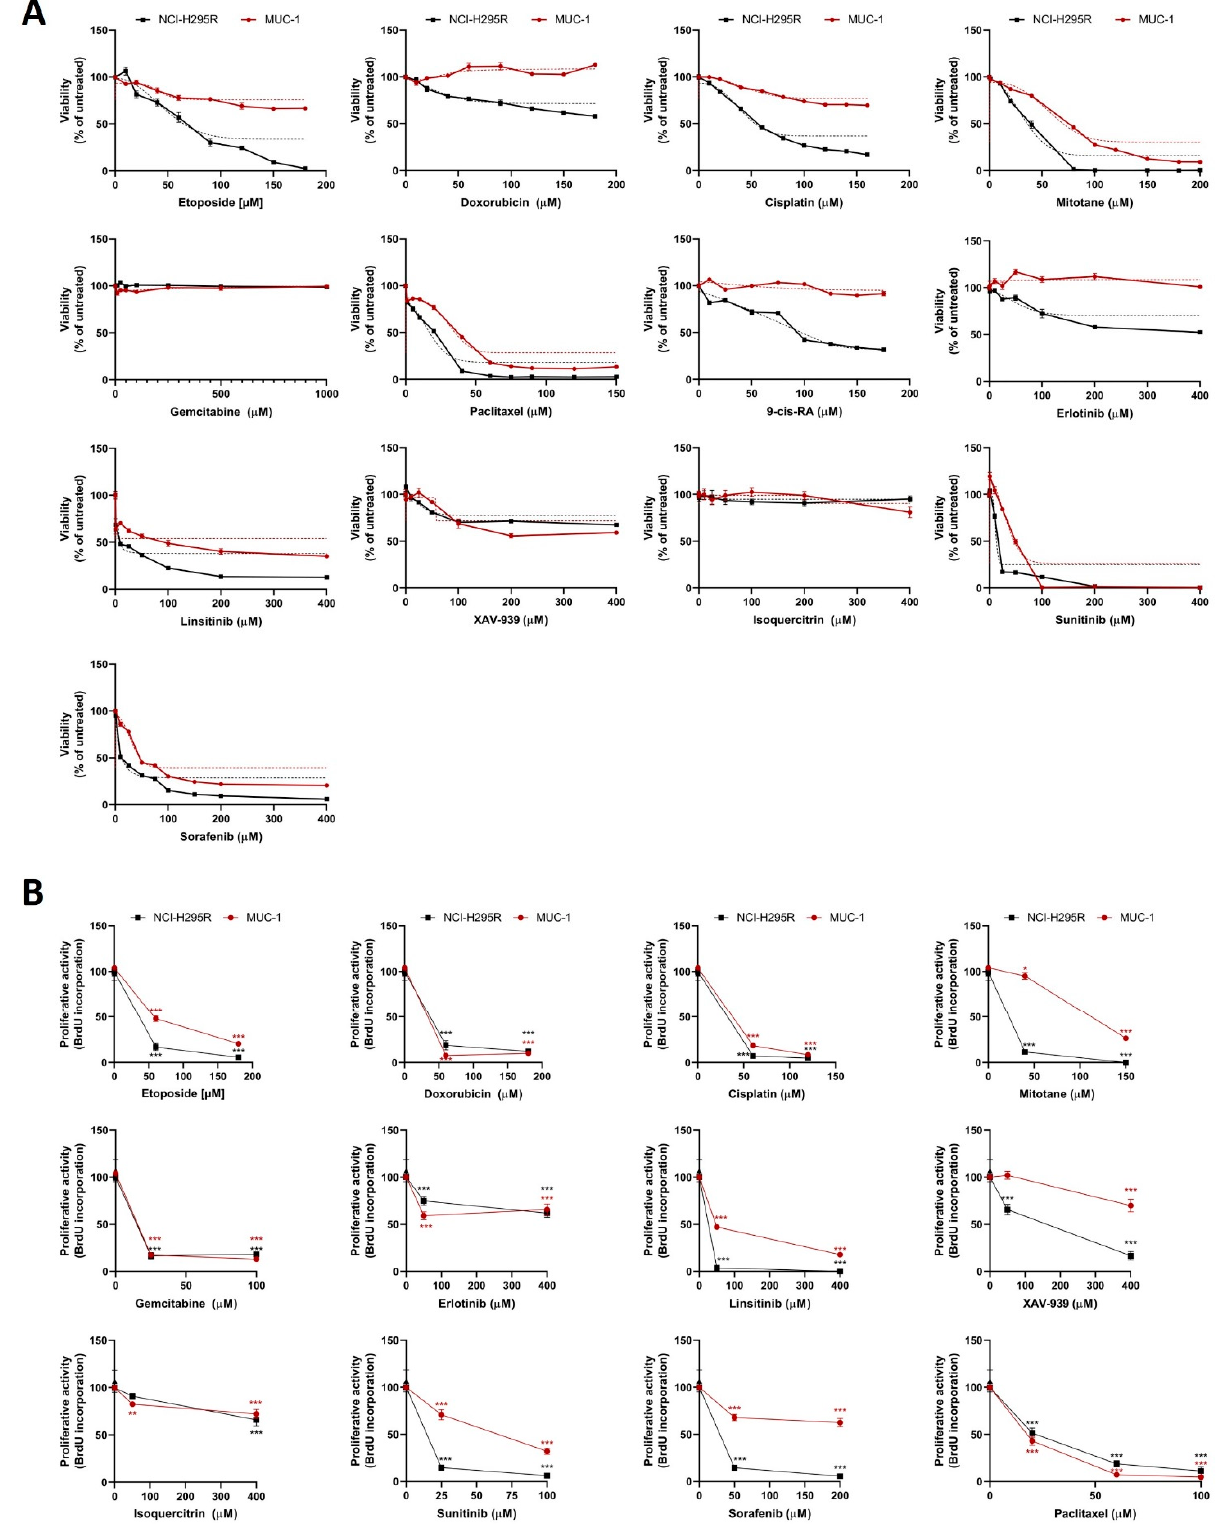
Figure 1. MTT viability assay of NCI-H295R and MUC-1 cells for different chemotherapeutic agents incubated for 24 h in the indicated concentrations ( A ). BrdU proliferation assay: both cell lines were incubated for 24 h with different drug concentrations and were correlated with the respective control ( B ). Stars represent significance vs. nontreated (*, p < 0.05; **, p < 0.01; ***, p < 0.001).